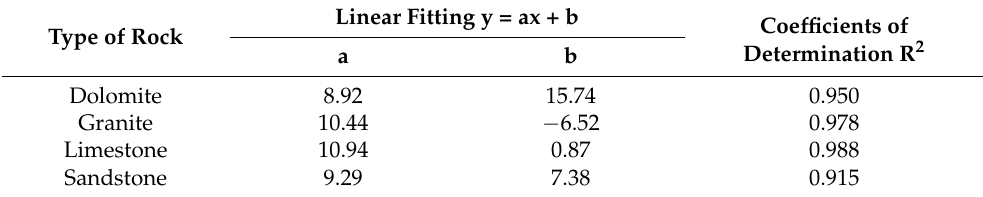
Table 4. Linear relationships between UCS and E ni of different rock